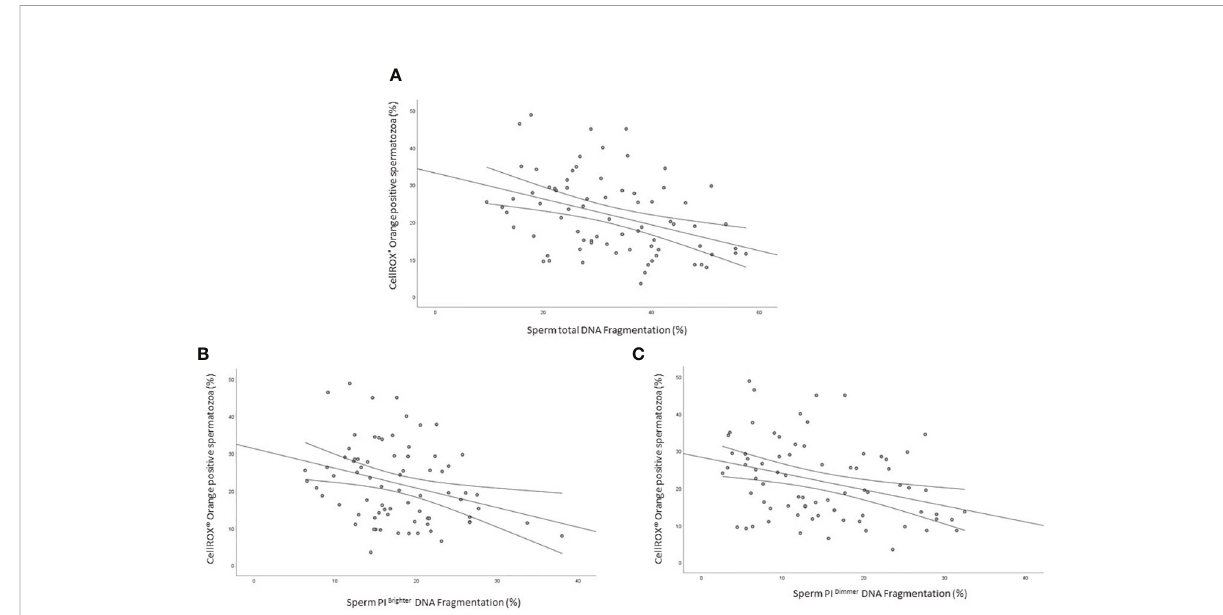
FIGURE 5 Scatter plots representing the relationship between the percentage of CellROX ® Orange positive spermatozoa and total ( A , R=-0.4, p<0.01), PI Brighter ( B , R=-0.3, p<0.05) and PI Dimmer ( C , R=-0.3, p<0.01) DNA fragmentation in 76